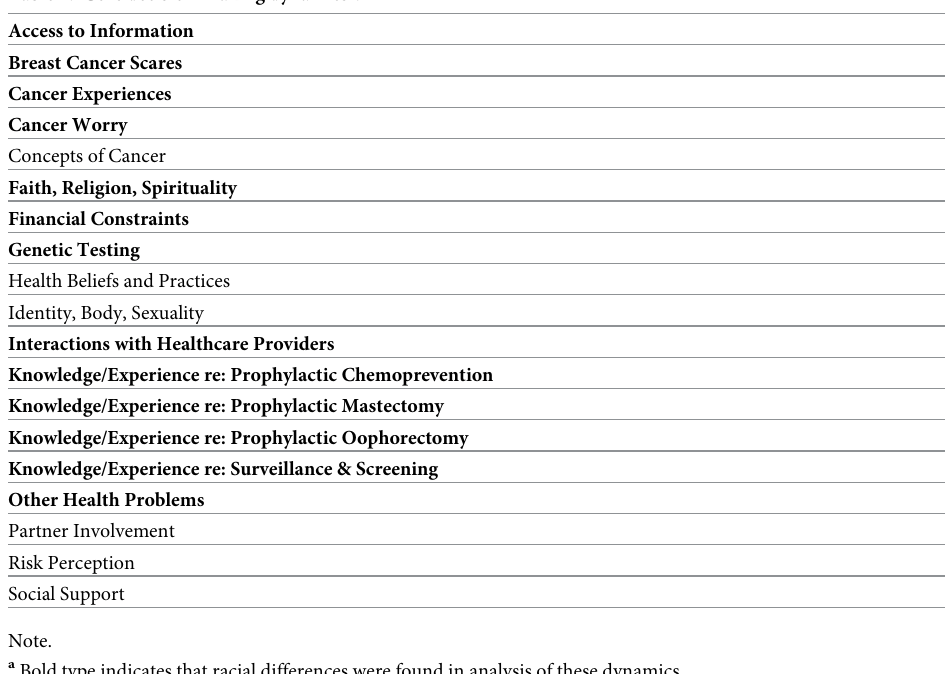
Table 2. Core decision-making dynamics a